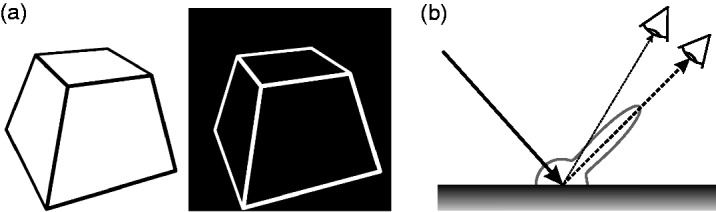
(a) Two perspective line drawings of a truncated pyramid with inverted
intensities similar to the stimuli used by Dove (1851). The stereoscopic
fusion of these two half-images makes the stimulus appear lustrous
(stimulus is arranged for uncrossed viewing). (b) The reflective
behavior of a glossy surface can be described by the BRDF—the
bidirectional reflectance distribution function (Nicodemus, Richmond, Hsia, Ginsberg,
& Limperis, 1977). Since the specular component
(represented by the specular lobe) is directionally selective, the two
eyes of an observer generally receive different amounts of light from
the same surface point (dashed arrows).